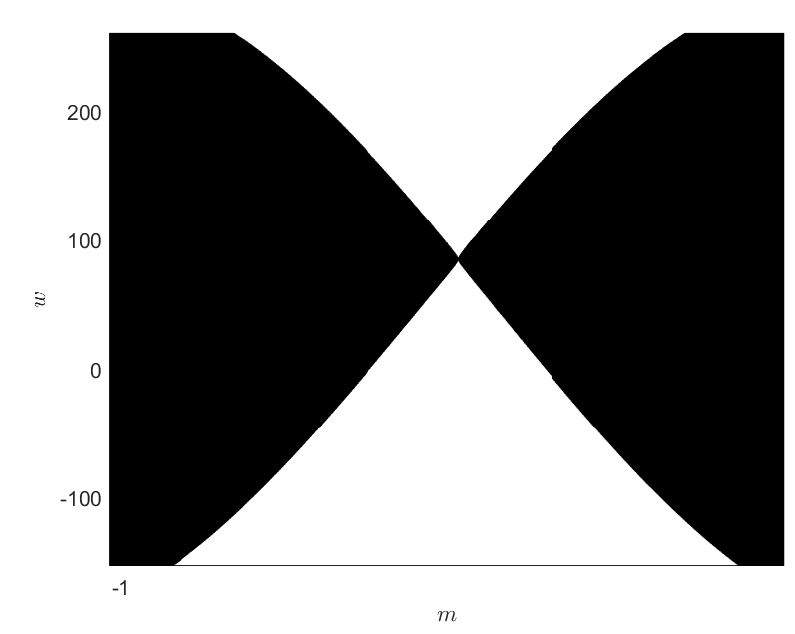
Figure 5. Gray image of the top view angle of Figure 4. Figure 4. Simulation example of D-FrFT Figure 5. Figure 6 is the structure of M-CNN. The input is the gray image obtained by processing the spectral map of the reflected signal. The pixels of the grayscale image are 112